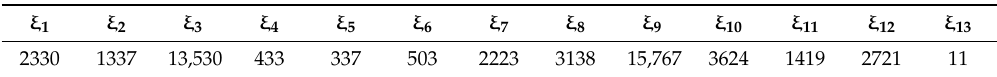
Table 2. Parametric coe ffi